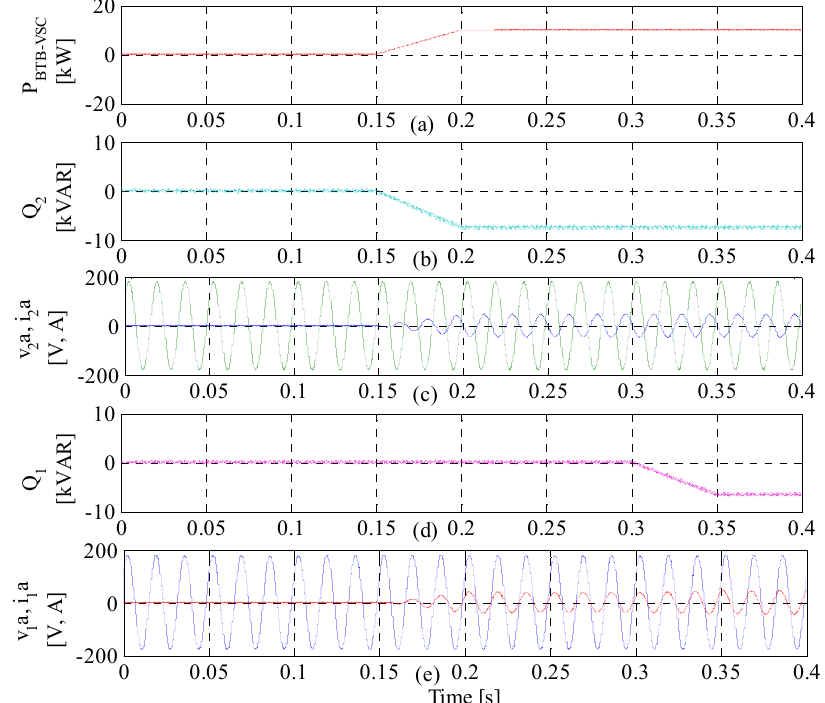
Figure 8. abc currents for Case 8. ( a ) TR1. ( b ) TR2. ( c ) Z L 11 . ( d ) Z L 12 . ( e ) Z L 21 . ( f ) Z L 22 . ( g ) BTB-VSC.